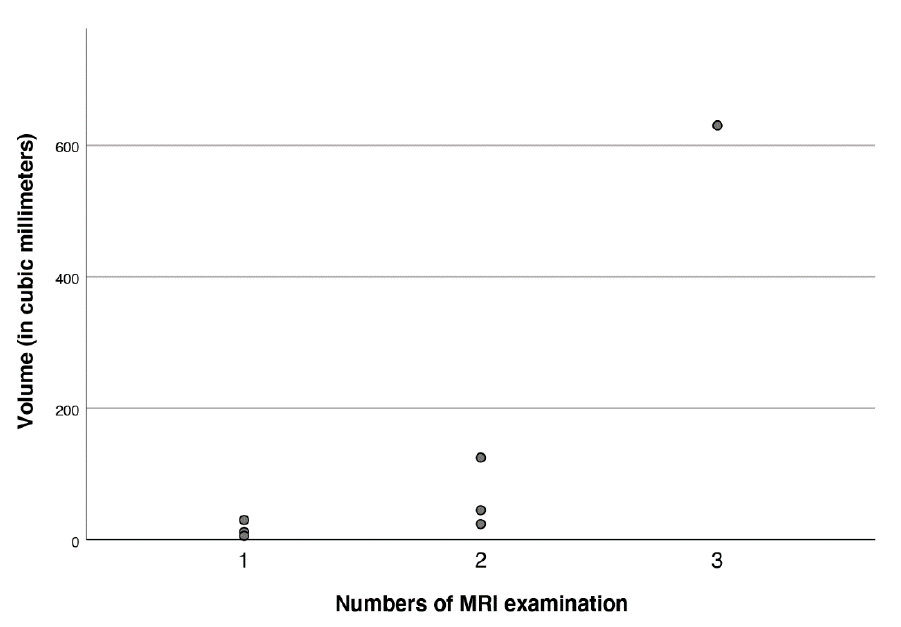
Figure 4. Volumes (in cubic millimeters) of the brain tissue lesions in relation to the numbers of MRI examinations.